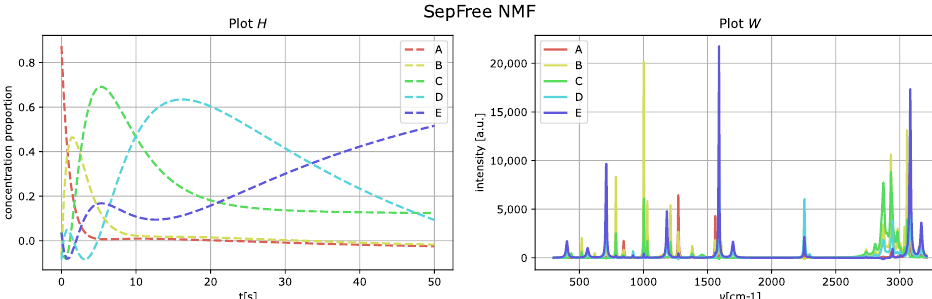
Figure 4. Reconstructed component-spectra of the compounds W on the ( right ), and reaction ki- netics H on the ( left ) the for noiseless and well-separated synthetic Raman dataset. Parameter set [ − 0.001, − 10.0,1.0,0.0,0.0 ] . Minimal memory effect det ( S ) = 0.002.